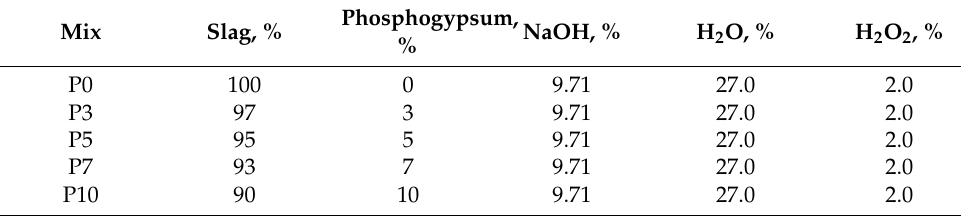
Figure 5. The particle size distribution of phosphogypsum. Table 3. The composition of the mixtures and the use of initial materials,